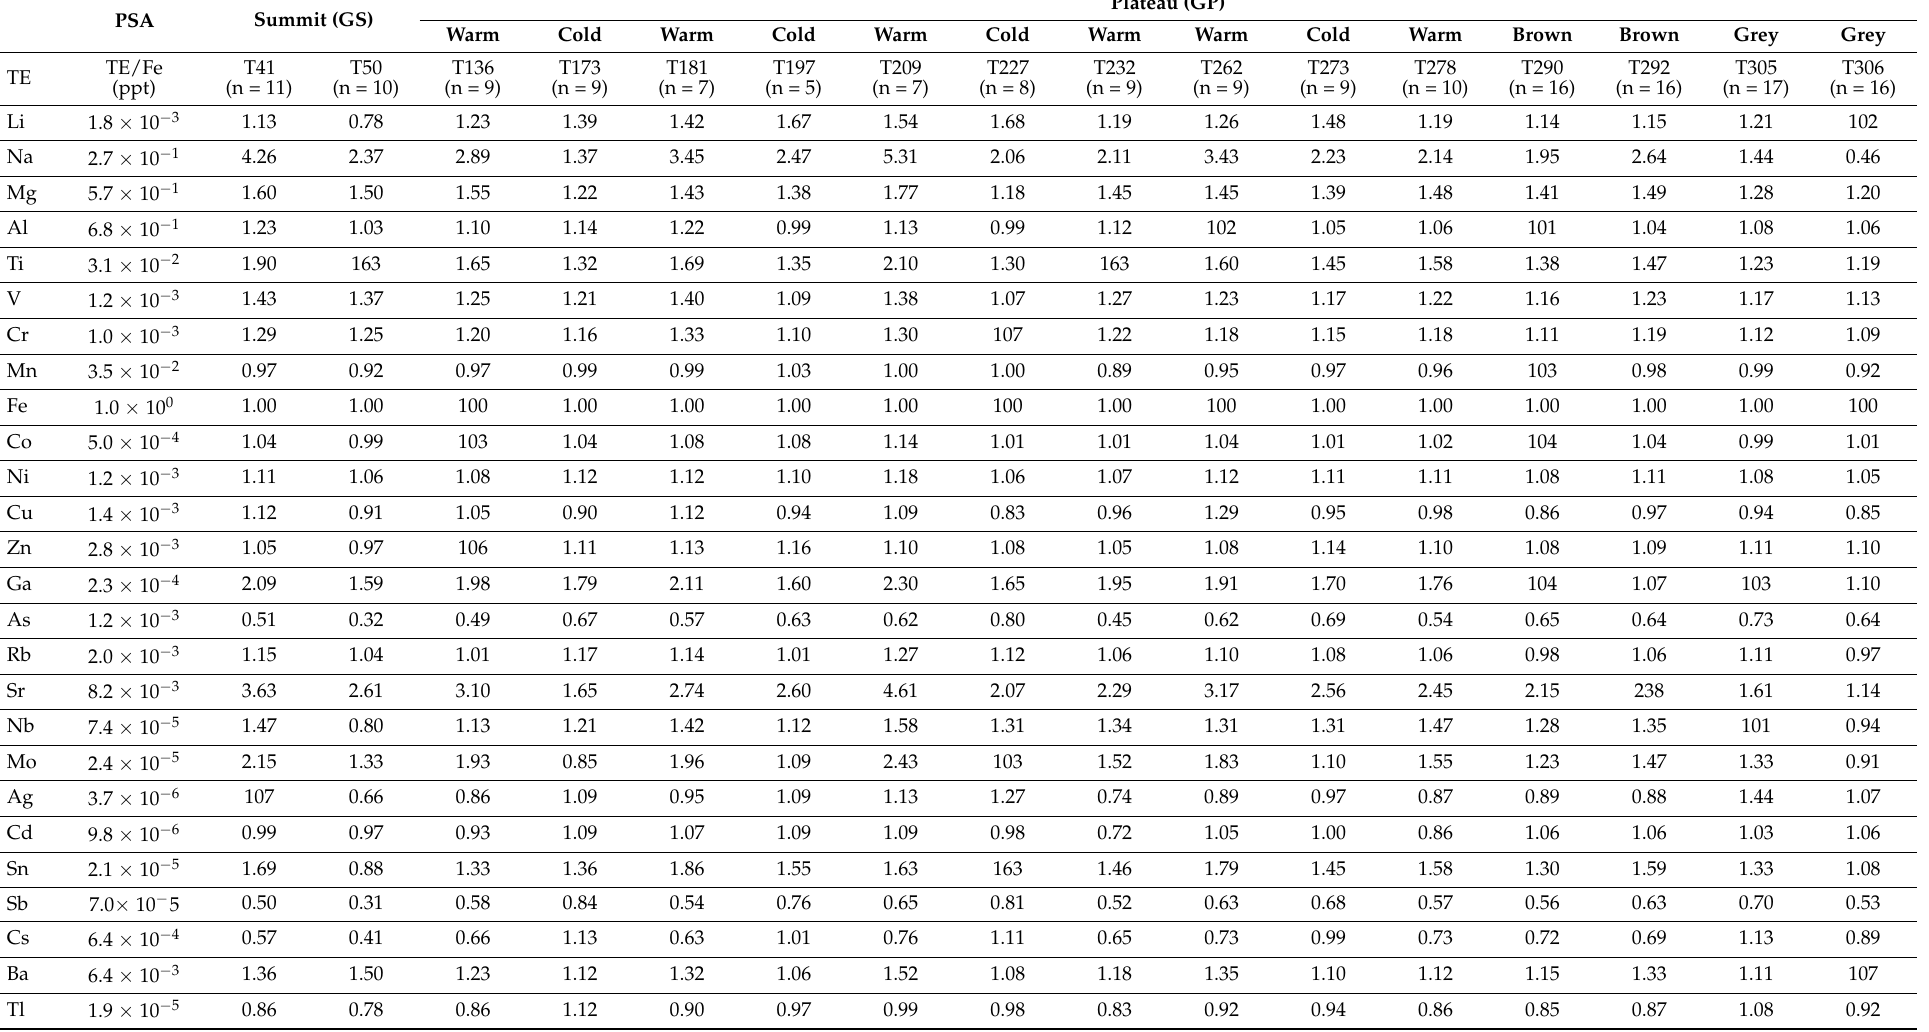
Table A2. Average TE enrichment factor in ice samples relative to local PSAs [55]. Fe is the crustal TE of reference.